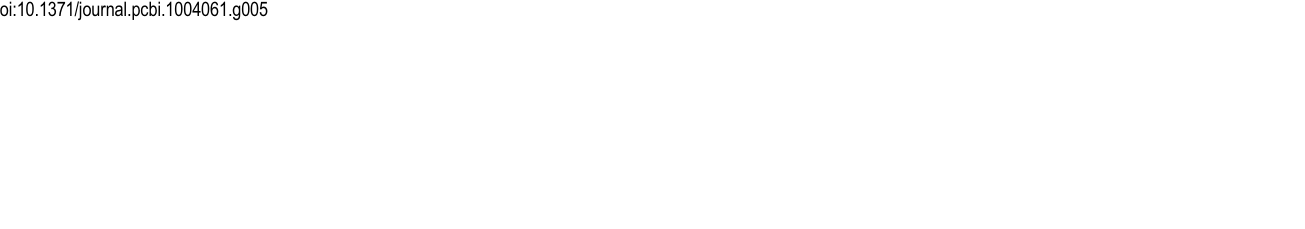
PLOS Computational Biology | DOI:10.1371/journal.pcbi.1004061 April 7,